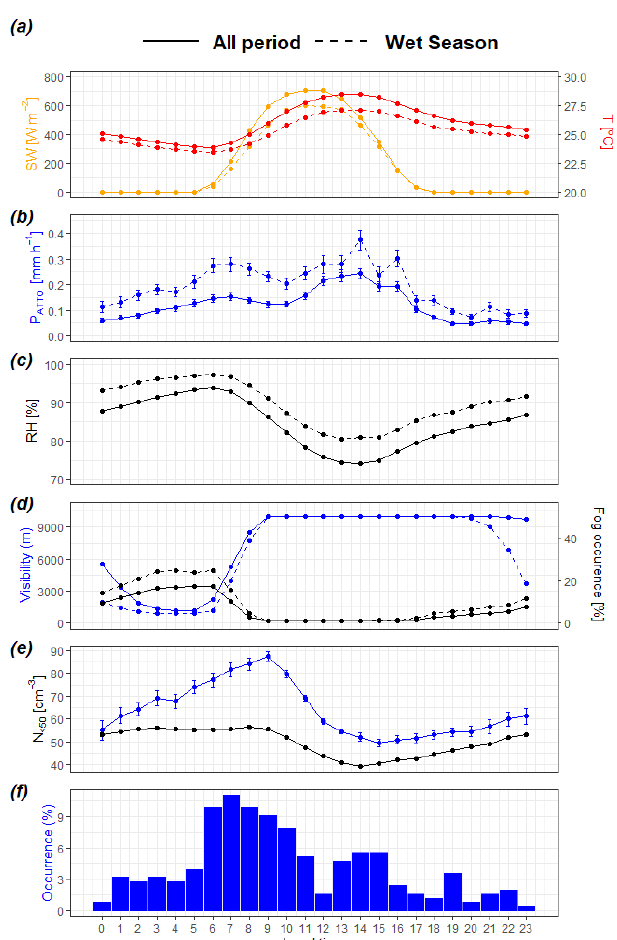
Figure 7. Diurnal cycle of selected meteorological parameters and the diurnal occurrence of particle growth events. From top to bot- tom: (a) incoming shortwave radiation (SW, orange) and air temper- ature ( T , red) at 26m (canopy level) height, (b) average local rain rate ( P ATTO , blue), (c) relative humidity (RH) at 26m, (d) visibility (blue) measured by a fog monitor and fog occurrence (black) with lines representing the first quartile, (e) median diurnal cycle of N <50 for all data (black) and only for the days on which particle growth events were observed (blue), and (f) the diurnal cycle of the particle growth event onsets. All error bars denote the standard error. The data shown represent all observations (full lines) and wet-season subsets (dashed